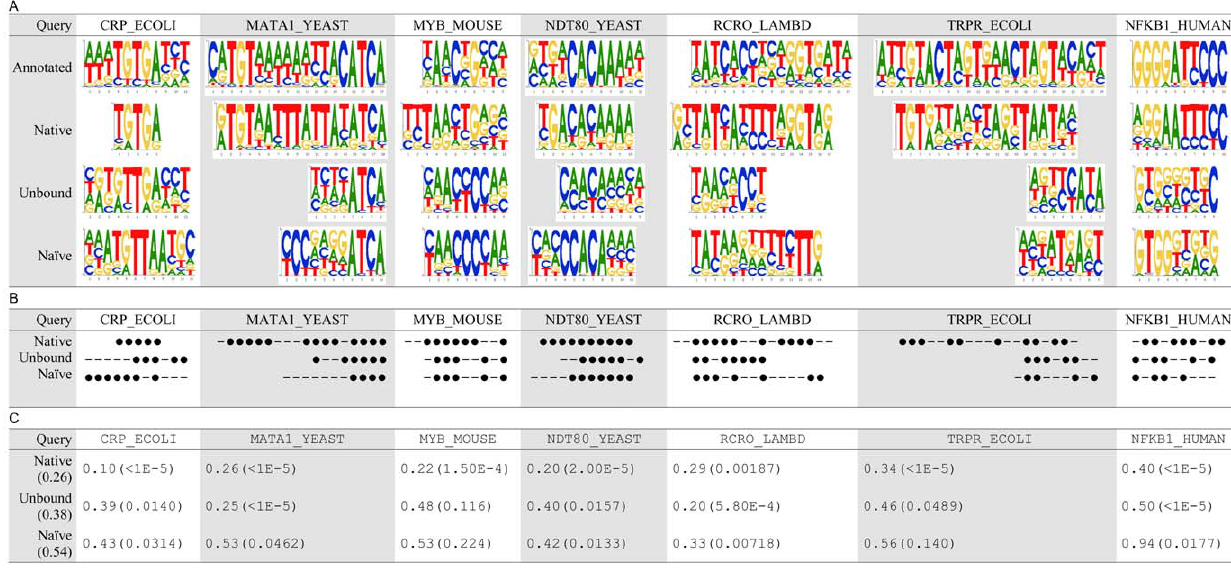
Figure 2. Predictions by the proposed method on the seven test cases. The predictions of the proposed method are denoted as ‘Unbound’, in comparison with the annotated PWMs (‘Annotated’), the predicted PWMs based on native complexes (‘Native’) and the complexes of homologues N (‘Naı¨ve’). (A) PWMs. (B) A position is marked as ‘ ’ if its most favorable base type was correctly predicted, or marked as ‘–’ otherwise. (C) Y -scores and the corresponding p-values. The value within the parentheses of the first column indicates the average Y -score.